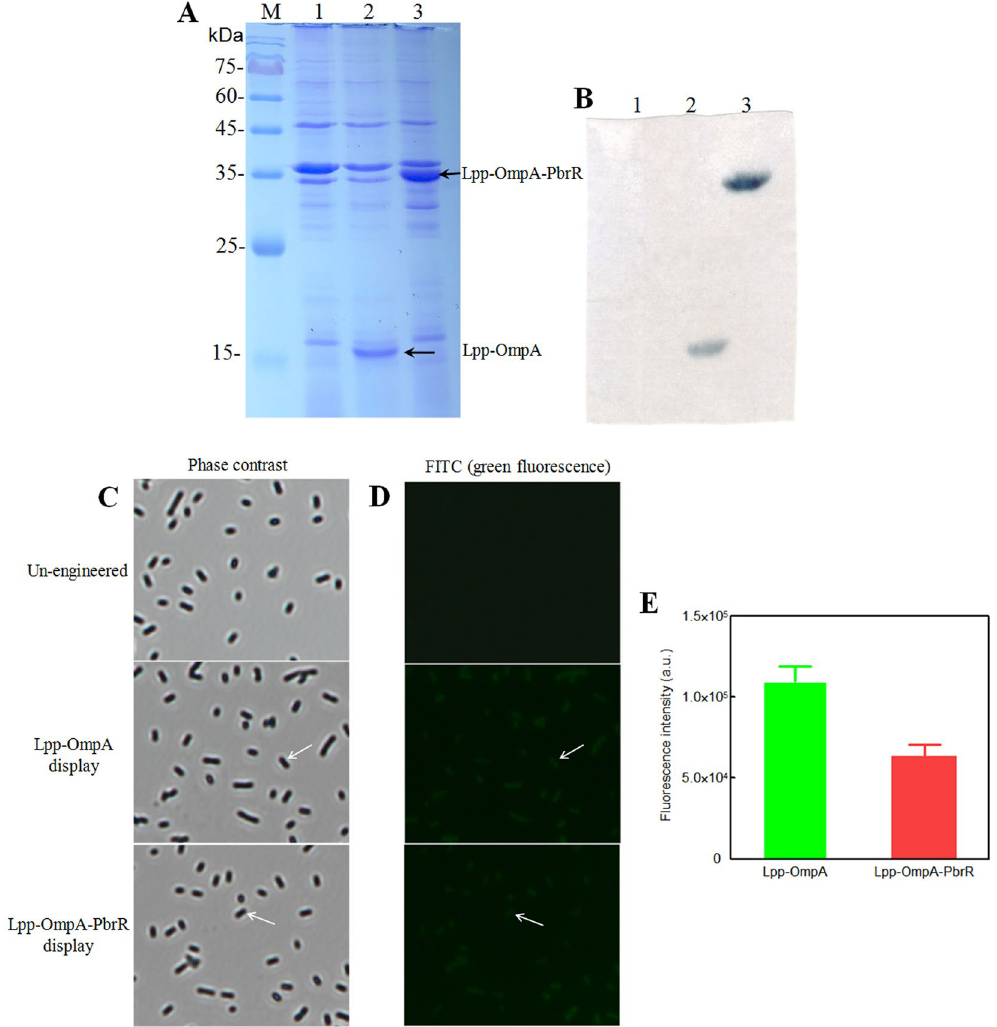
Figure 2. 15% SDS-PAGE, immunoblotting and immunofluorescence analysis of surface engineered E . coli . Total cell proteins were separated by 15% SDS-PAGE ( A ). Western blot of recombinant proteins probed by anti-His antibody ( B ). Lane 1 shows BL21(DE3)pLysS/pLA without induction; Lane 2 shows BL21(DE3)pLysS/ pLA after induction ( ≈ 17.4 kDa); Lane 3 shows BL21(DE3)pLysS/pLAP after induction ( ≈ 33.5 kDa); Lane M is a protein size marker. Phase contrast micrographs ( C ) and immunofluorescence images ( D ) of recombinant E . coli cells. Immunofluorescence labeling of surface-engineered E . coli cells using mouse anti-His tag antibody (primary antibody) and FITC labeled donkey anti-mouse IgG antibody (secondary antibody). White arrows indicate individual cells that have been immunofluorescence labeled. Immunofluorescence was performed using a fluorescence microscope ( × 1000 magnification). Fluorescence intensities of Lpp-OmpA and Lpp- OmpA-PbrR displayed E . coli cells ( E ) were obtained by subtracting the fluorescence intensity of un-engineered cells. Results shown represent the mean values of three independent